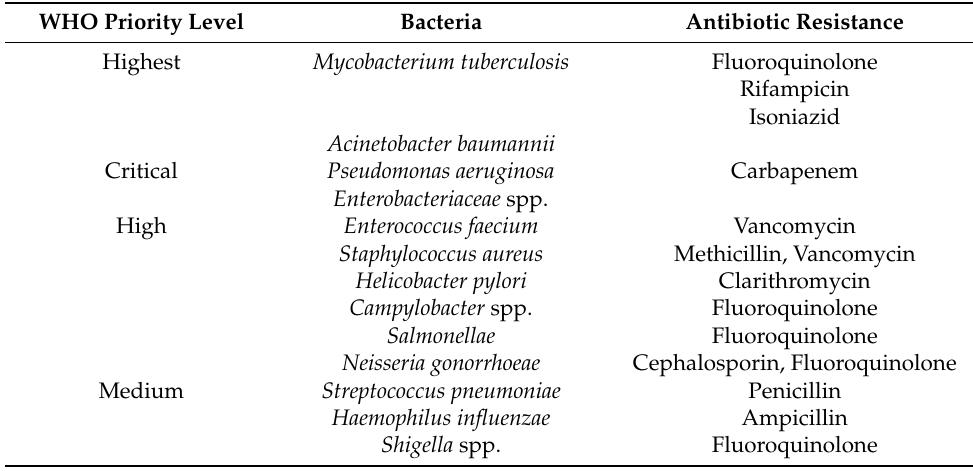
Table 2. Types of bacteria that are antibacterial resistant (from